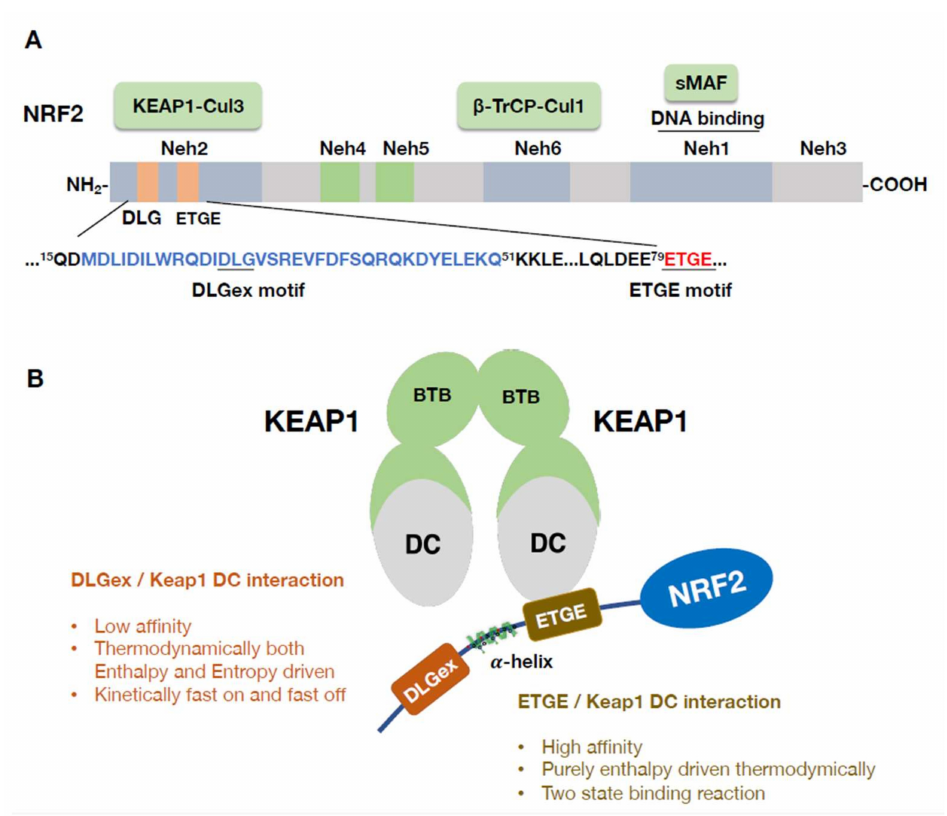
Figure 3. ( A ) Domain structure of NRF2. NRF2 is made up of six functional domains: Neh1-Neh6. The Neh2 domain has DLG and ETGE motifs that bind to two different portions of the DC domain of KEAP1. The Neh1 domain is important for DNA binding because it forms a heterodimer with sMAF. Neh4 and Neh5 are transactivation domains. The Neh6 domain binds to the β -TrCP-CUL1 complex to mediate KEAP1-independent ubiquitination of NRF2. ( B ) The ETGE motif has a higher affinity than the DLGex motif for binding to the DC domain. The ETGE-KEAP1 DC interaction is much stronger than that of DLGex-KEAP1 DC interaction. ETGE-KEAP1 DC binding is exclusively enthalpy driven and has been shown to elicit a two-state binding reaction. This difference in binding affinity forms the basis of the binding/hinge and latch model of the KEAP1–NRF2